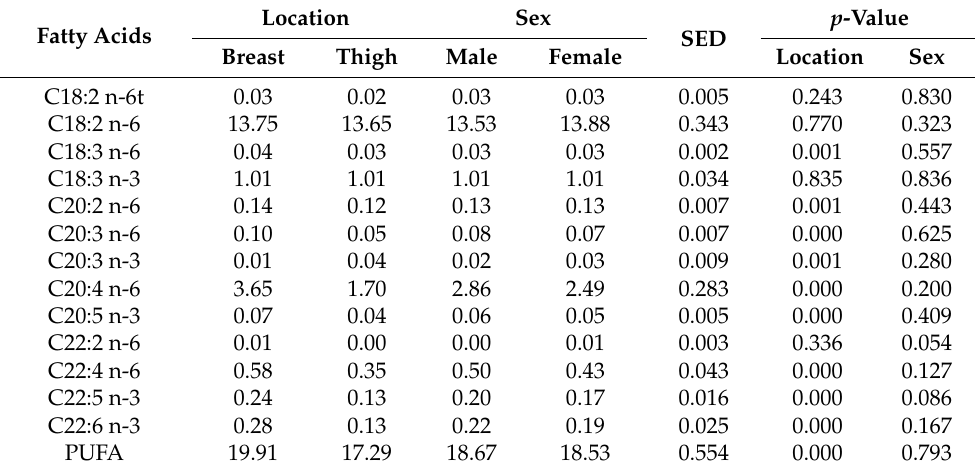
Table 10. Effects of muscle anatomical location and sex on polyunsaturated fatty acid (% of total FA) composition of goose meat